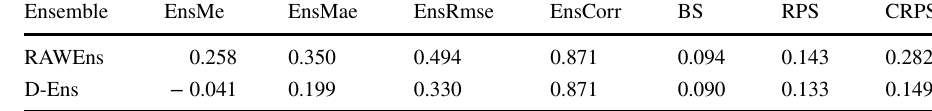
Table 2 Deterministic verifications and probability scores